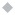
Experimental procedure.The experimental procedure started at 2 PM, the day of surgery, and continued for the next 48-h, inclusive of the 24-h of IIT and the 24-h of control CIT, administered according to randomized, cross-over protocols. Patients (n = 5) assigned to protocol 1 started with IIT, followed by CIT, while patients (n = 5) assigned to protocol 2 started with CIT followed by IIT. Throughout the 2-day study, glycaemia was determined every 2 hours (▲). The stable isotope infusion to determine erythrocyte glutathione kinetics and oxidative stress, was performed during the last 7 h of insulin treatment, either IIT or CIT (i.e. from 7 AM to 2 PM). Shortly before starting the infusion (◆) a blood sample was taken to assess background isotope enrichments and hematochemical and oxidative stress indices. Blood samples were taken at time 3,4,5,6,7 hour (▲) to assess the glutathione kinetics.